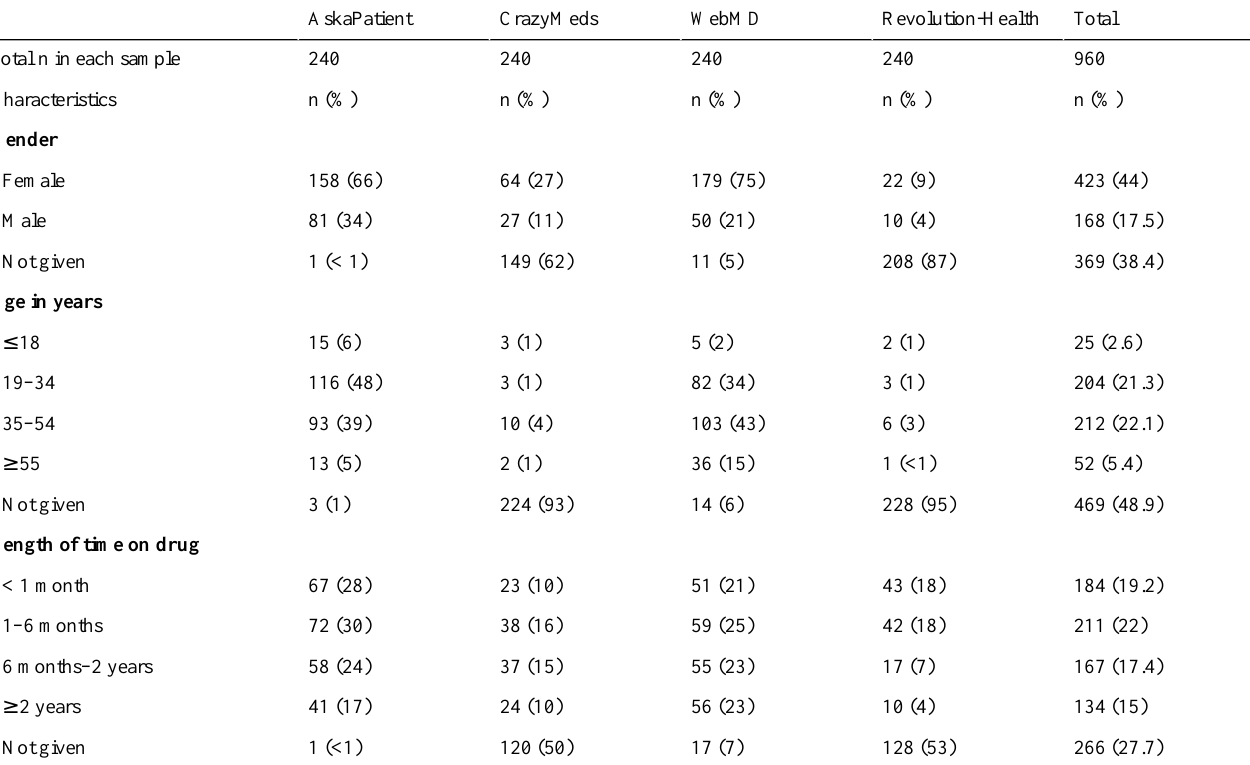
Table 2. Consumer characteristics according to website